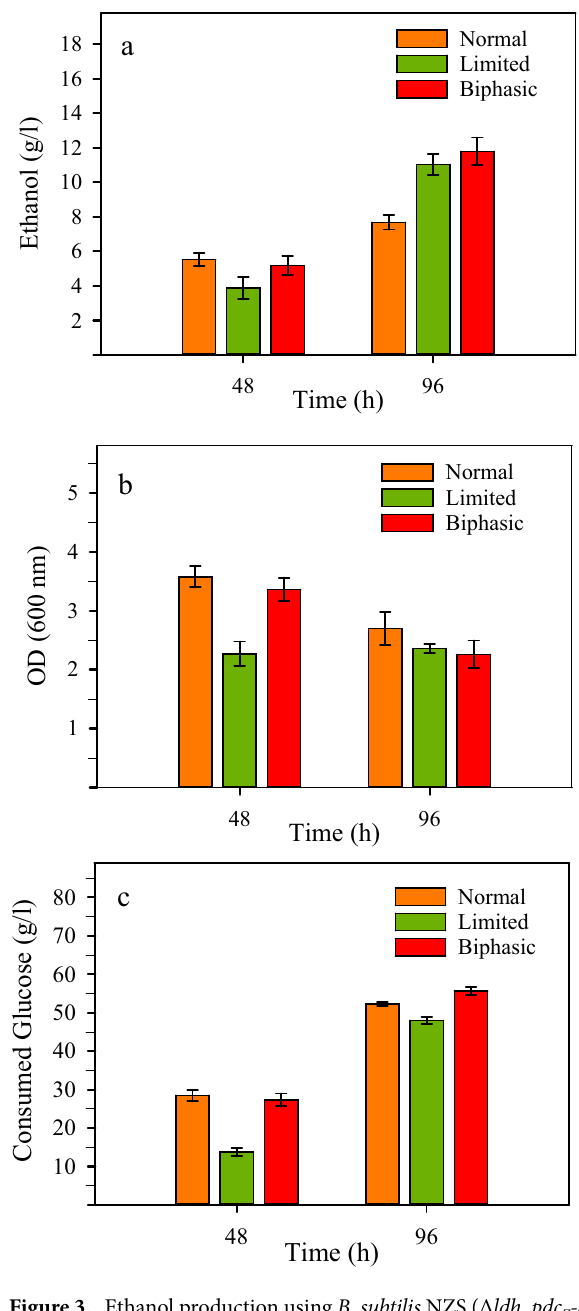
Figure 3. Ethanol production using B. subtilis NZS (Δ ldh , pdc Z -adh S ) under various aeration conditions. Cultures were conducted for 96 h in a shaking incubator at 37 °C and 180 rpm under the normal, limited, and biphasic aeration conditions. Samples were taken at 48 h and 96 h of fermentation and analyzed for: ( a ) ethanol production, ( b ) cell growth, and ( c ) glucose